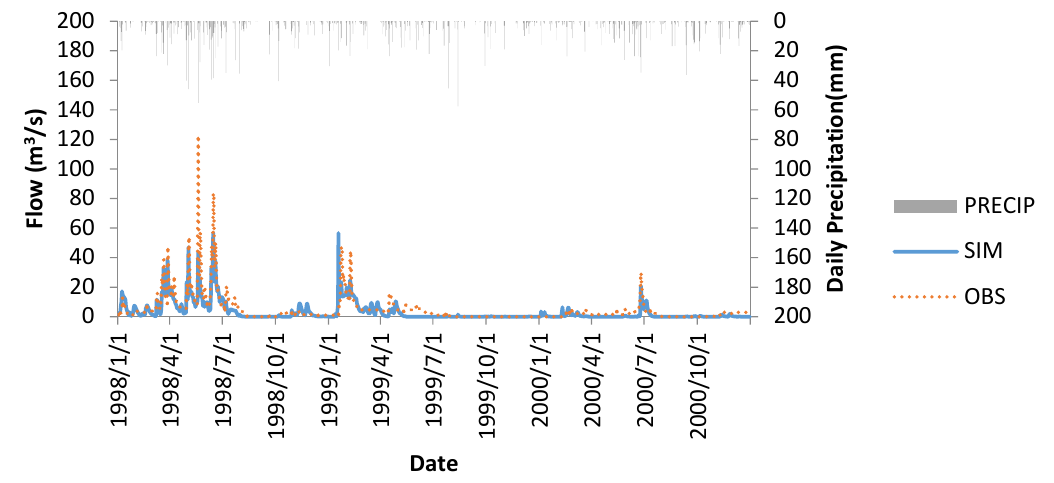
Figure 2. Comparison of daily observed and simulated flow at the watershed outlet (1998–2000).